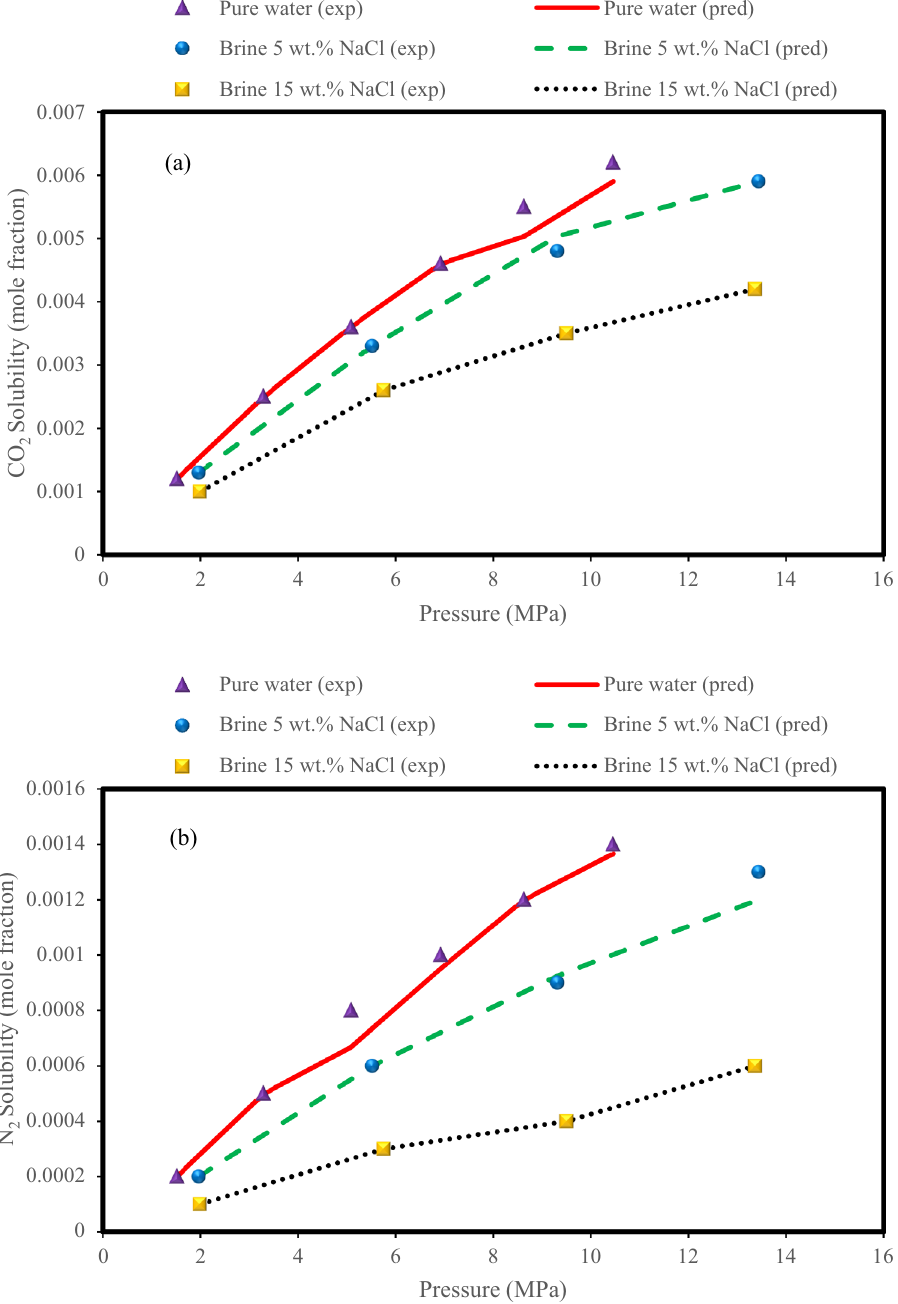
Figure 10. Effect of salinity on ( a ) CO 2 solubility and ( b ) N 2 solubility in the N 2 (85.4%) + CO 2 (14.6%) + H 2 O (brine) systems at a temperature of 273 K; experimental data 10 with predictions of the Random Forest